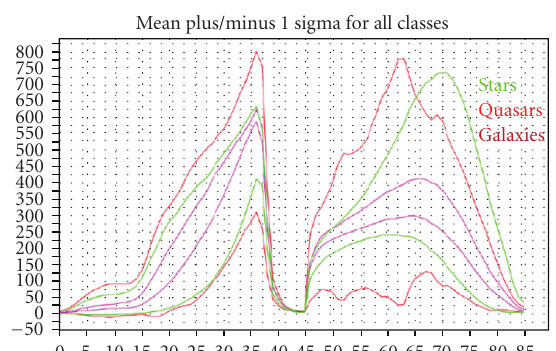
Figure 10: The simulated 1D low dispersion spectra by Gaia according to Bailer-Jones et al., 2008 [17]. The x-axis in pixels covers the BP and RP range, on y-axis is the intensity (arbitrary units). This picture shows that even for very low dispersion spectra without visible spectral lines valuable information can be obtained and scientifically used from the spectral continuum